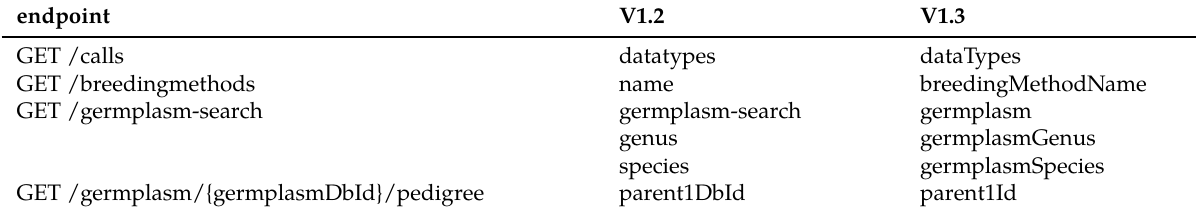
Table 3: Examples for the evolution of API for FAIR-IPK implemented endpoints. endpoint